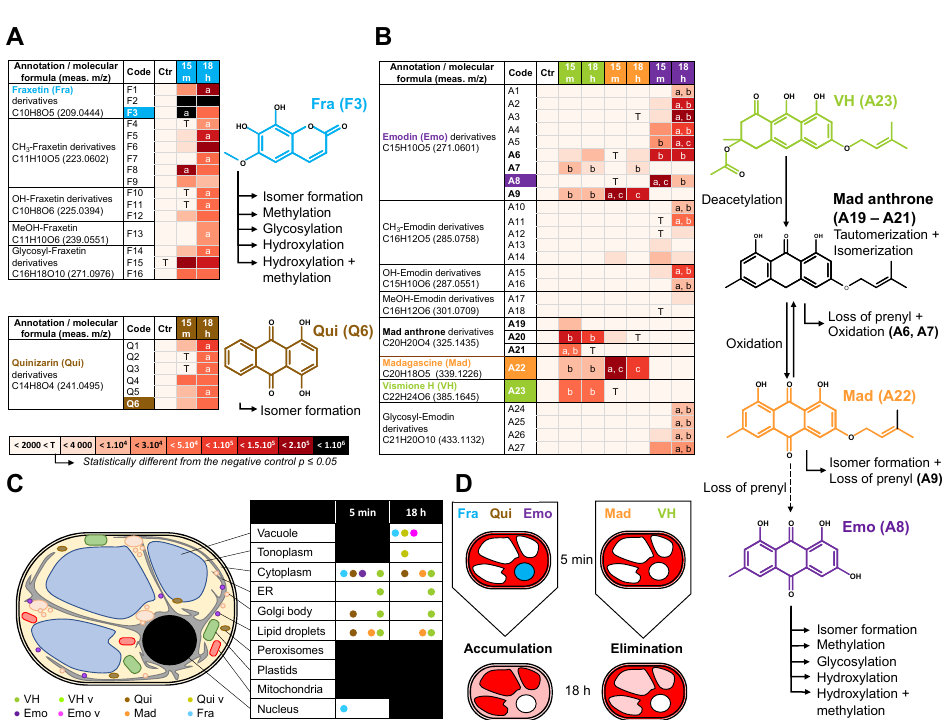
Figure 6. Hypothetical metabolization reactions according to non-targeted analysis of treated BY-2 cells. m/z of parent and daughter ions from references and related metabolites detected by UPLC-HRMS/MS analysis of methanolic extracts from BY-2 cells treated for 15 min (15 m) and 18 h with ( A ) 50 µ M of fraxetin Fra (blue), ( B ) quinizarin Qui (brown), or ( C ) vismione H VH (green), emodin Emo (purple) and madagascine Mad (orange). meas. m/z = measured mass to charge ratio of the most intense adduct detected. Proposed reactions such as hydroxylation (+OH), methylation (+CH 3 ), hydroxylation/methylation (+MeOH), glycosylation (+Sugar) and loss of prenyl which may occur in the metabolization processes. The arrows indicate hypothetical reactions according to the references (colored label) and 54 annotations absent or with an area below the significant threshold in negative control samples (<4000). Statistical analysis was performed on area from annotated metabolites ( n = 3) using Levene with Kruskal–Wallis tests followed by a Dunnett’s post-hoc test. Significant differences ( p ≤ 0.05) between area of metabolites from (a) BY-2 cells treated 15 min and 18 h or (b (cid:54) = c) between treatments with anthranoids. ( D ) Conjuncture of the fluorescence localization in BY-2 subcellular compartments observed by SImaging and the non-targeted metabolomic analysis proposing that Fra, Qui, and Emo derivatives accumulate into the vacuole, while not prenylated anthranoids VH and Mad being mostly metabolized into other sub-cellular